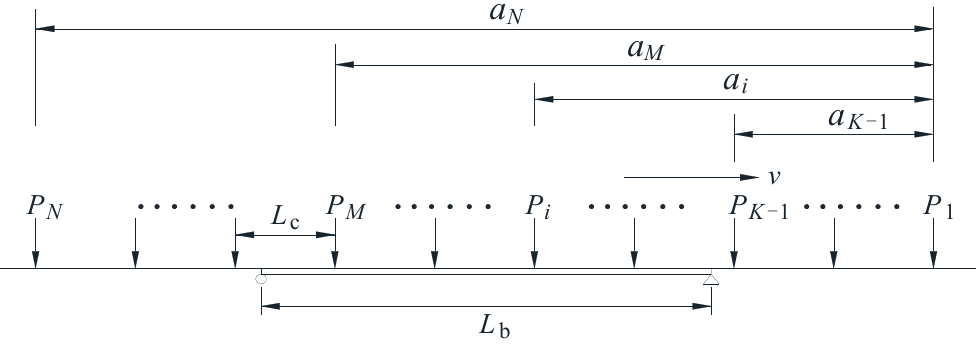
Figure 7. Simplified schematic diagram of the bridge subjected to a moving train.